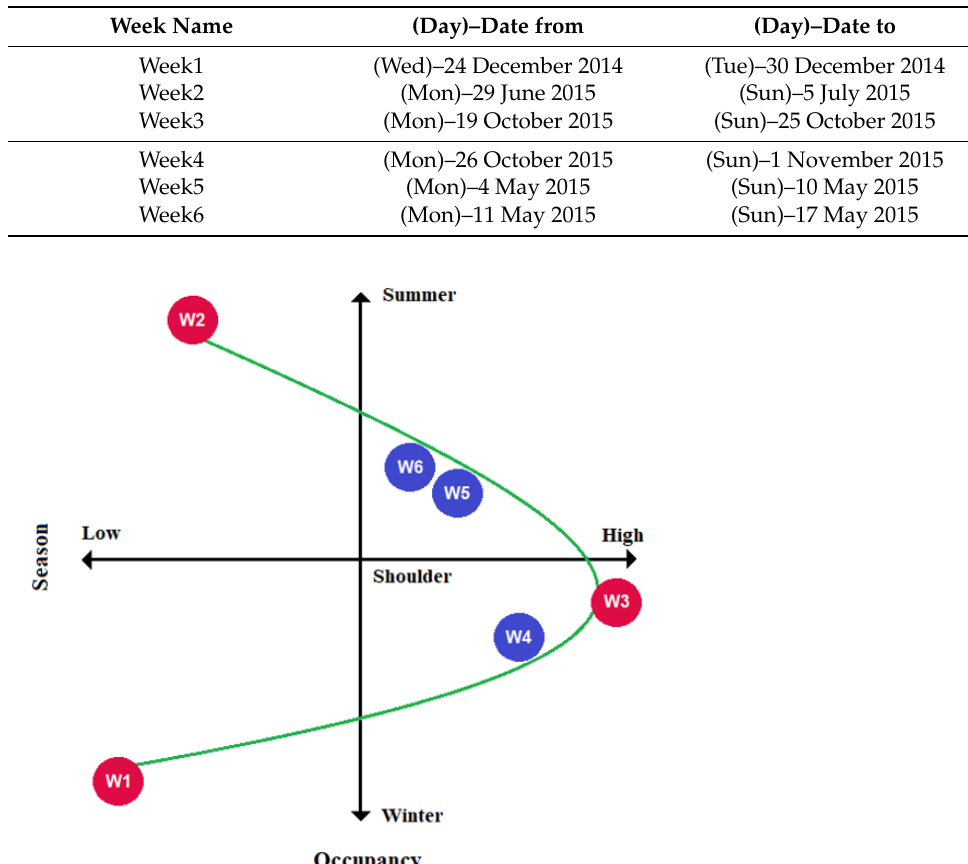
Table 2. Periods used to calibrate or validate the GB model or WB model.